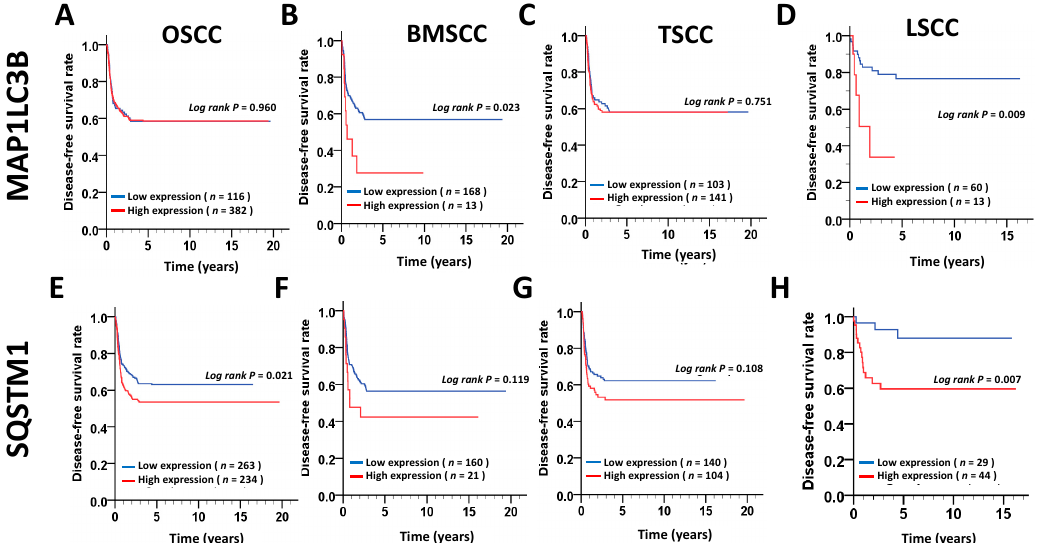
Figure 4. DFS survival curves for MAP1LC3B and SQSTM1 expression in patients with different subsites of OSCC. DFS survival curves of MAP1LC3 ( A – D ) and SQSTM1 ( E – H ) are shown for OSCC ( A , E ) and three main subsites, BMSCC ( B , F ), TSCC ( C , G ) and LSCC ( D , H ). The cutoff values for high or low expression of MAP1LC3B and SQSTM1 on tumor tissues were based on the receiver operating characteristic (ROC) curve.